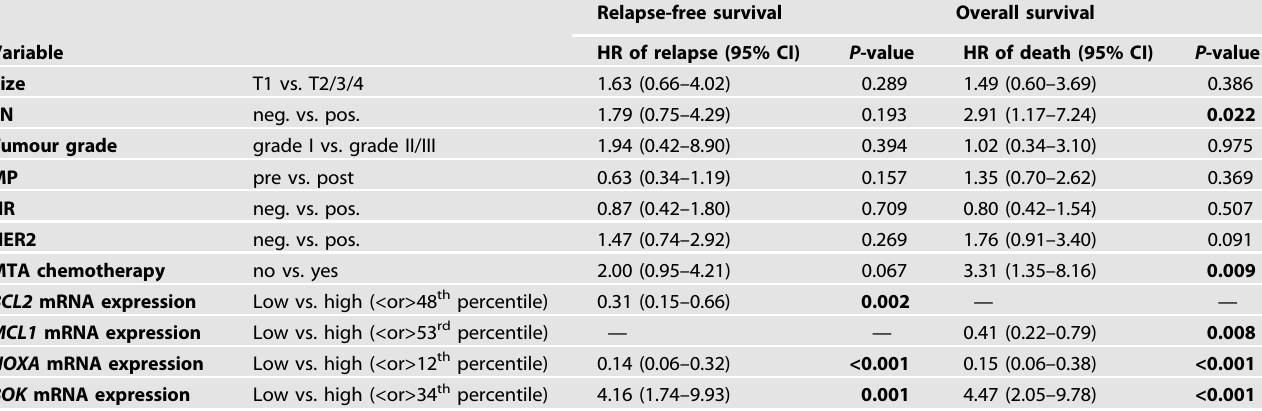
Table 2. Multivariate Cox-regression analysis of relapse free survival and overall survival of 92 patients with primary breast cancer diagnosed and treated at the Medical University of Innsbruck,